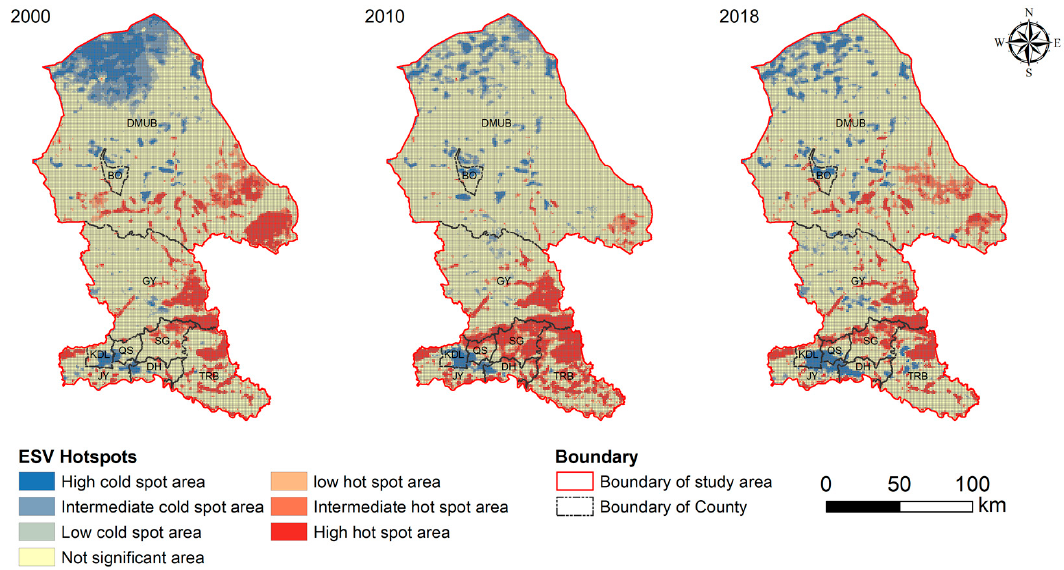
Figure 7. Spatial aggregation characteristics of ESV in Baotou from 2000 to 2018.